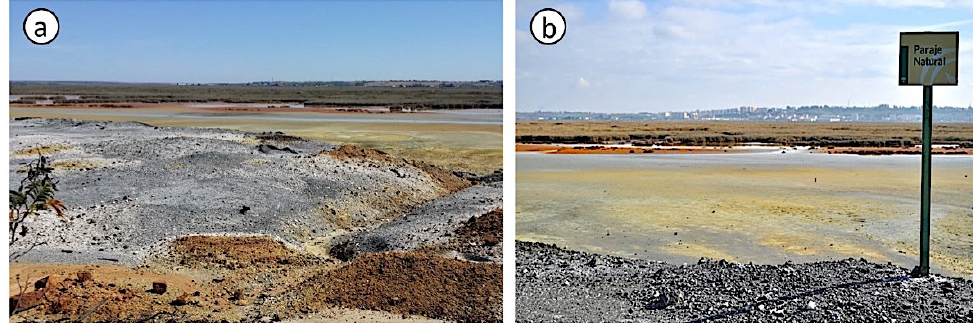
Figure 1. Field pictures of the degraded land area showing the abandoned stockpiles of crushed pyrite ore ( a ) and the salt marsh soil affected by the acid drainage ( b ).